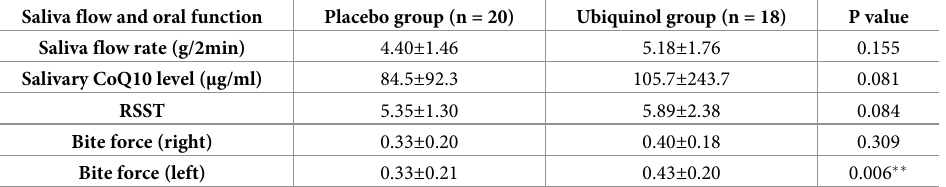
Table 2. Baseline characteristics of the